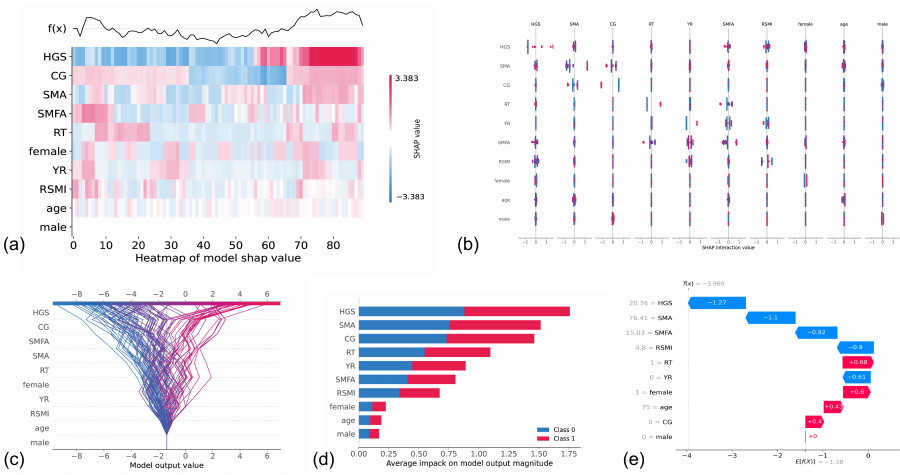
Figure 6. A summary plot of the SHAP values of all features of the stacking model. The y-axis indicates the different features. HGS: handgrip strength. ( a ) illustrates heat map of various feature SHAP values, where the x -axis represents the sample sequence, red represents positive impact, and blue represents negative influence; the deeper the hue, the higher the degree of effect. f ( x ) denotes the output (before activation function). If the output is positive, the graphic illustrates that the most essential characteristic has a positive influence. ( b ) represents the interaction SHAP values of several characteristics, demonstrating the interaction effects between them. ( c ) illustrates the cumulative process for each sample and each feature of the model, and the x -axis indicates the final predicted value. ( d ) denotes the average absolute SHAP value of different features; the x -axis denotes the average SHAP value. The handgrip strength contributed the most to predicting whether the post-intervention participant was a patient with sarcopenia. ( e ) illustrates the influence of features in a single sample, the x -axis represents the SHAP value. The handgrip strength contributed the most positive effect, and the RT had the most negative effect in predicting whether the post-intervention participant was a patient with